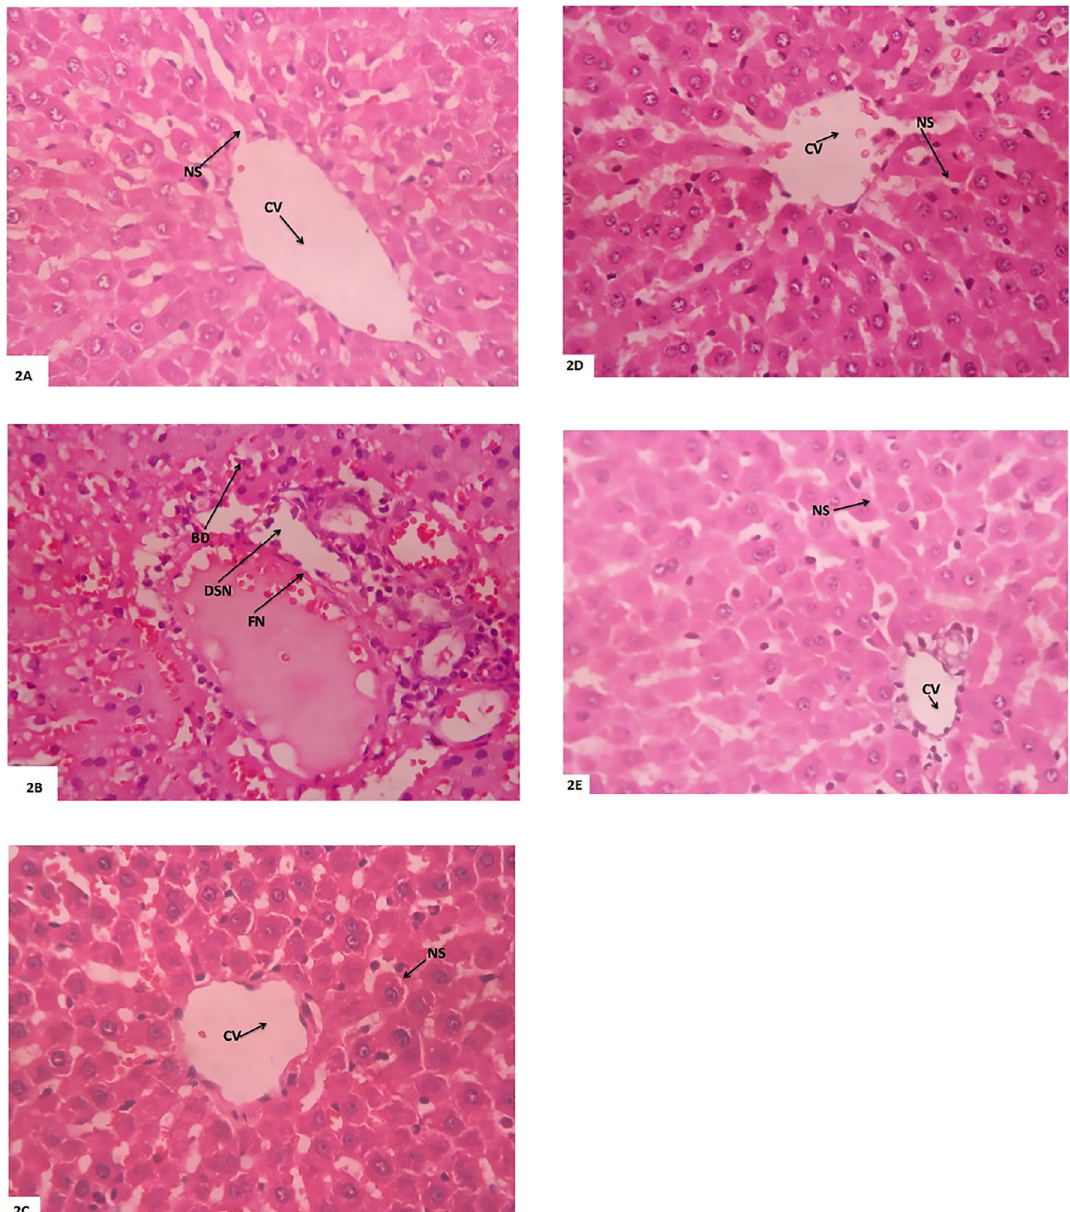
FIGURE 2 - A - Liver normal control; B-Diabetic control; C-Standard (glimepiride); D-Alcohol extract (100 mg/kg); E-Alcohol extract (200 mg/kg). CV-Central vein; NS- Narrow sinusoids; DSN-Dilated sinusoids; FN-Fatty necrosis; BD-Ballooning